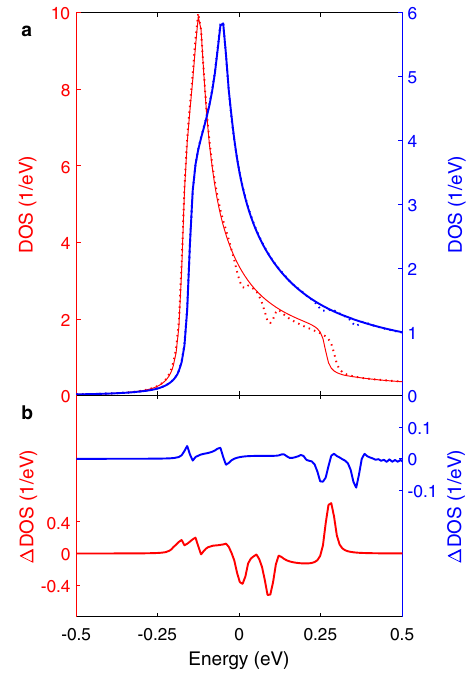
Fig. 5 Density of state of the two bands in the self-consistent calculations. a The red (blue) indicates the band making up the inner (outer) pockets; solid/dashed indicates the ungapped/gapped band structure, where gaps are included self-consistently at the mean- fi eld level. b Difference between the gapped and ungapped cases in a , showing small DOS suppressions at energies away from E F on both bands in addition to the gap at E F on the inner